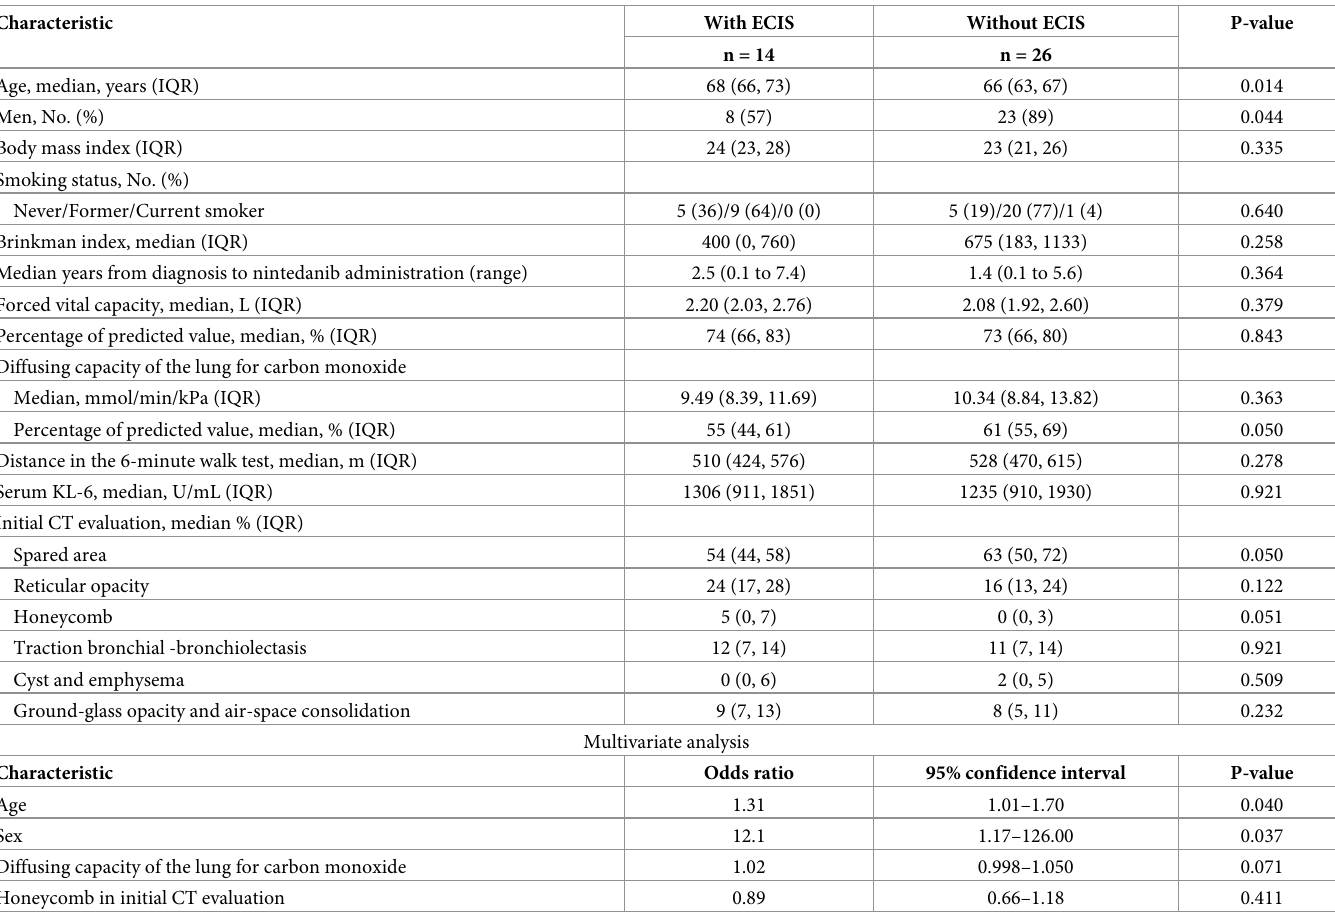
Table 3. Comparison of baseline characteristics in patients with or without ECIS in univariate and multivariate analysis.